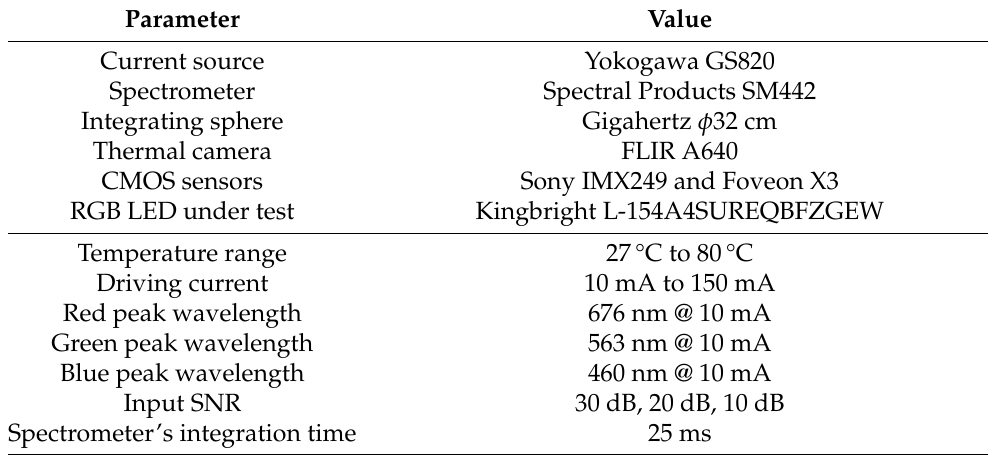
Table 1. Parameters of the experimental